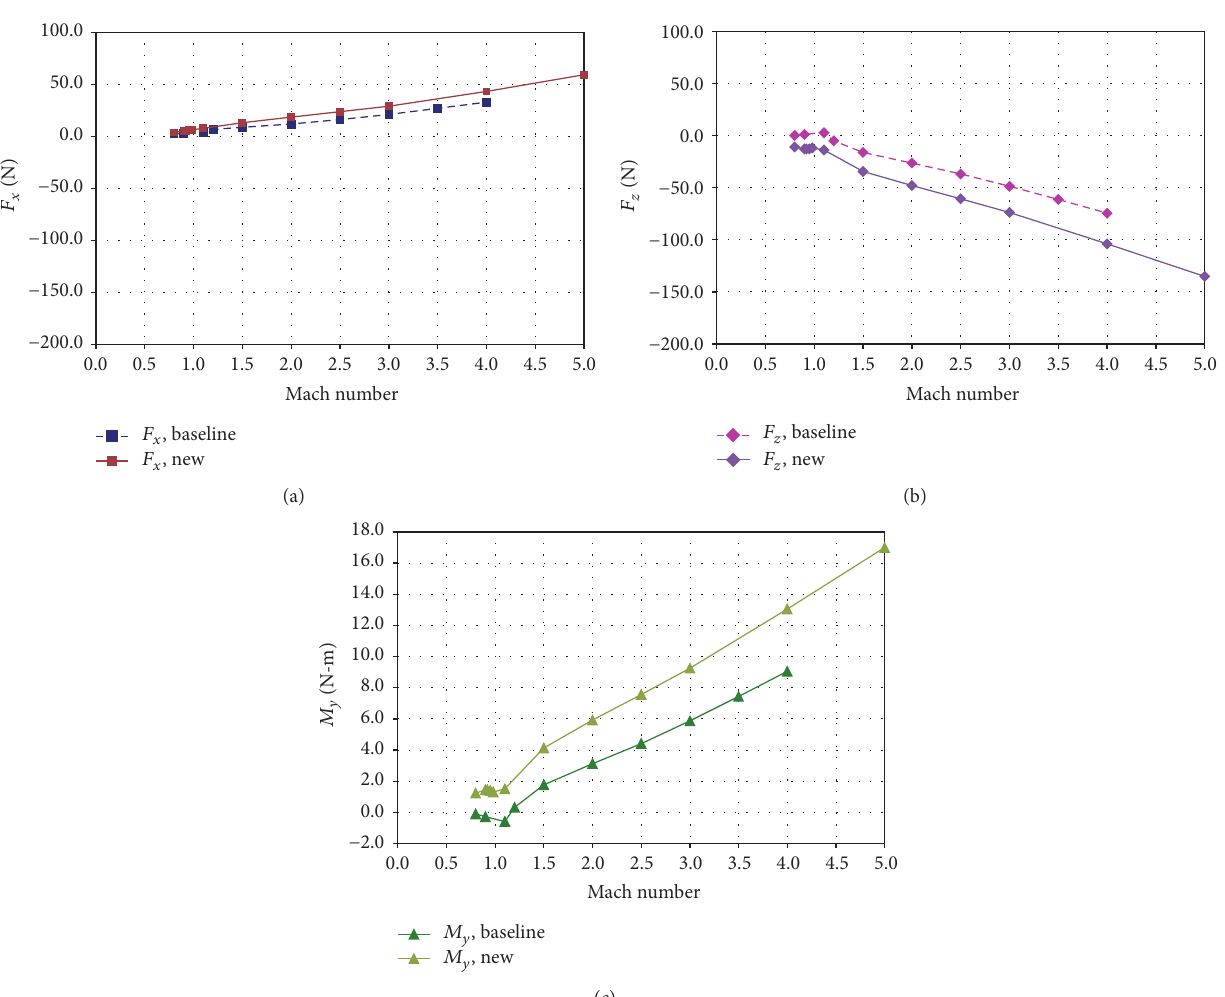
Figure 12: Variation of delta aerodynamic forces and moments due to microflaps as a function of Mach number for the 8-flap optimized configuration, 𝛼 = 0 ∘ : (a) delta forces and (b) delta moments.